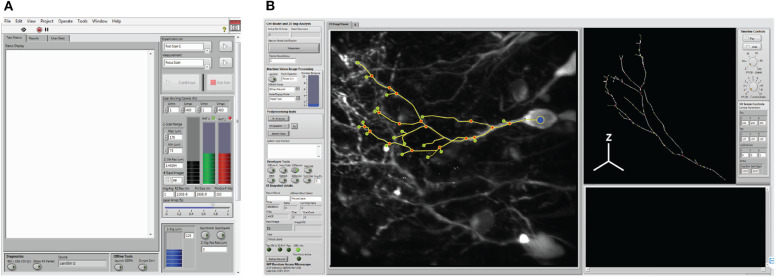
System user interfaces. (A) The measurement user interface (i.e., Msmt. UI) provides user access for hardware selection, and experimental design. (B) The cell trace and analysis toolkit user interface (CTAK UI) serves as an interface for drawing the initial 3D structure of the neuron, correcting minor positional errors following scans, and for post-analysis following either the F3DS or FSS routines.